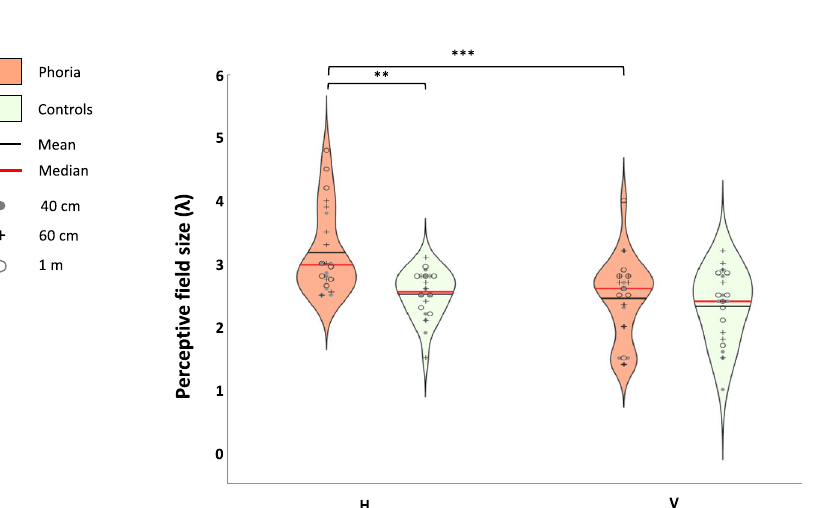
Table 3. Values of contrast detection threshold (in log unit) obtained for each group for the different target orientations at different viewing distances (Experiment 1). H stands for horizontal and V for vertical.